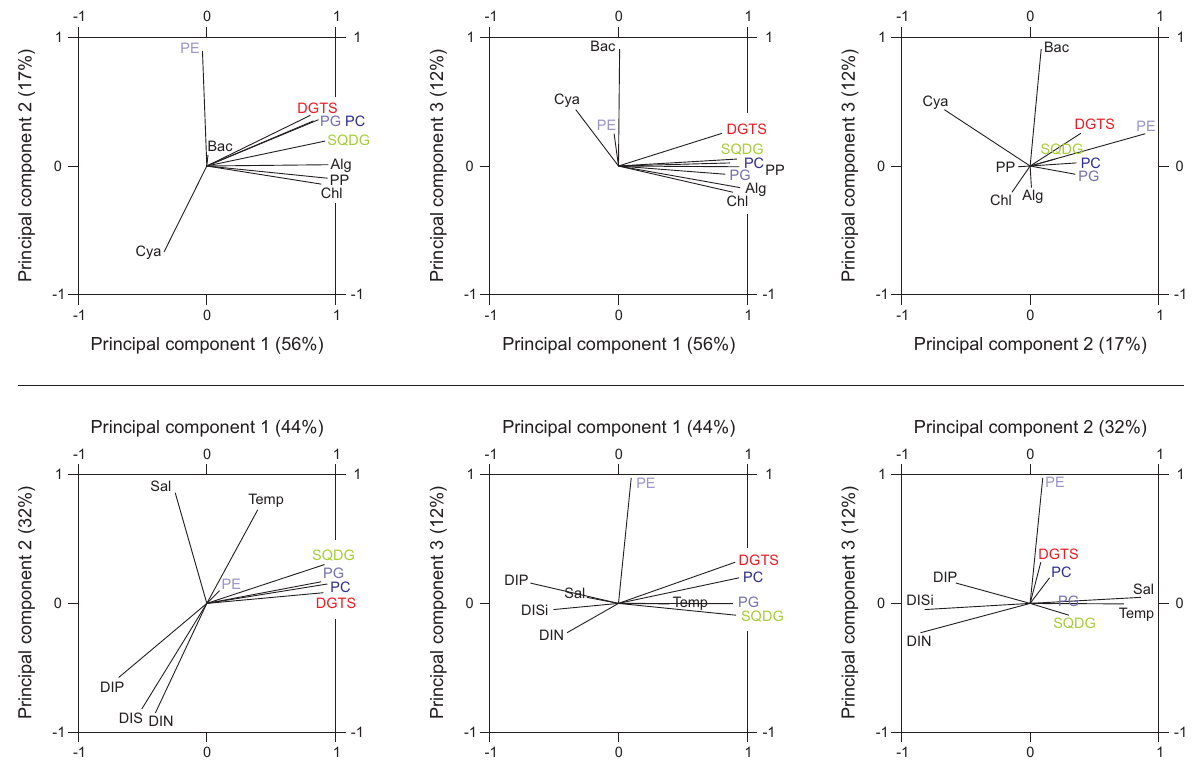
Fig. 6. Principal component analysis (PCA) plots for the total concentrations of the IPL classes with microbial abundances, chlorophyll a concentrations and primary productivity (upper panel), and with environmental parameters (lower